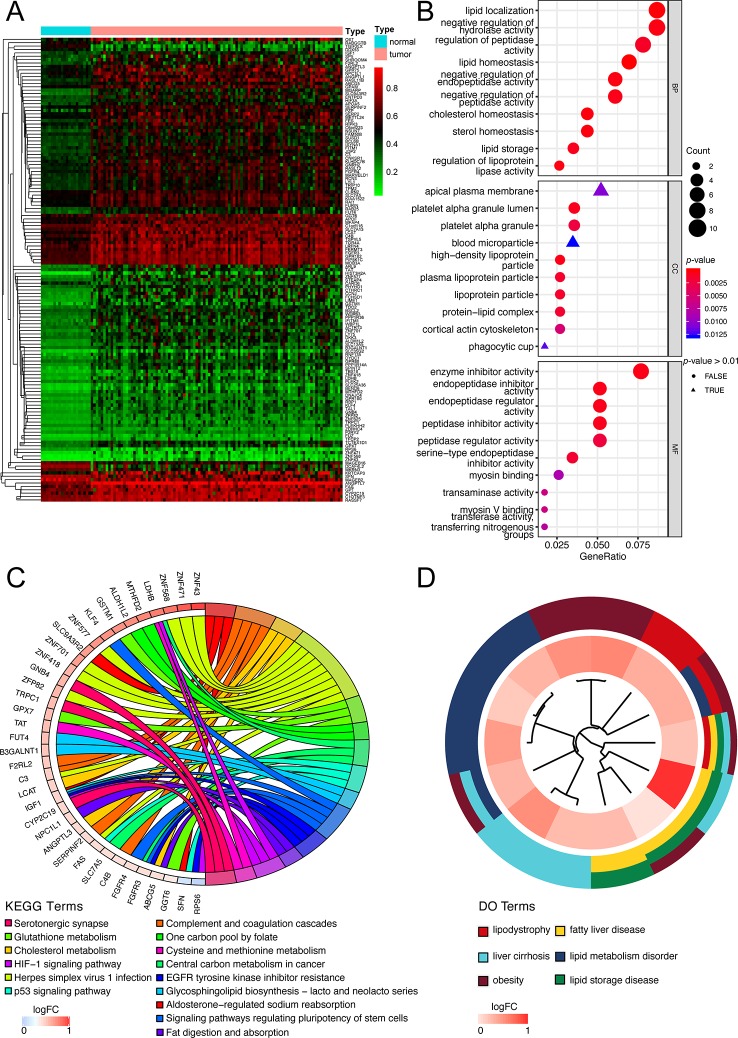
Functional exploration of MDGs. (A) Heatmap of 137 aberrant MDGs in non-viral hepatocellular carcinoma. The green color stands for hypomethylation while the red shows hypermethylation. (B) Gene Ontology (GO) analysis of 137 MDGs. Only top 10 terms of BP, CC, and MF were shown and the complete data were in Table S3. (C) KEGG pathway analysis of 137 MDGs. The color of curves represents different KEGG terms; The left semi-circle color means different gene expression and the corresponding genes are labeled. The P-value of all terms is < 0.05. (D) Disease Ontology (DO) analysis of 137 MDGs. The inner circle is composed of different genes and their expression (LogFC) while the outer circle consists of different DO terms. The P-value of shown DO terms is < 0.05. Only liver-related terms were exhibited and the whole results were in Table S5.